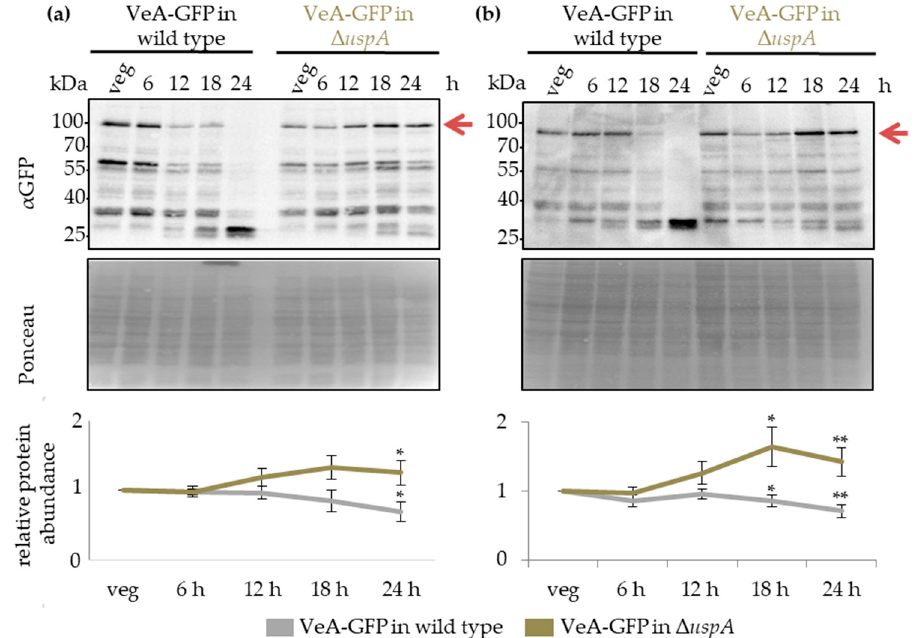
Figure 8. UspA prevents the accumulation of VeA-GFP during multicellular development. Strains were grown in submerged culture for 20 h at 37 ◦ C (veg) and shifted onto solid agar plates containing equal amounts of minimal media. Plates were incubated for 24 h at 37 ◦ C in light and in darkness to induce asexual ( a ) or sexual ( b ) development, respectively. Samples were taken every six hours. Protein crude extracts were prepared to analyze the abundance of VeA-GFP fusion protein during developmental stages in wild type or ∆ uspA background strains through western blot experiments. The quantification of the VeA-GFP fusion protein abundance is based on five biological with two technical replicates each. Error bars represent the standard error of the mean). Significances were calculated with t-test and always normalized to the Ponceau staining and the fusion protein abundance during vegetative growth (* p ≤ 0.05; ** p ≤ 0.01).